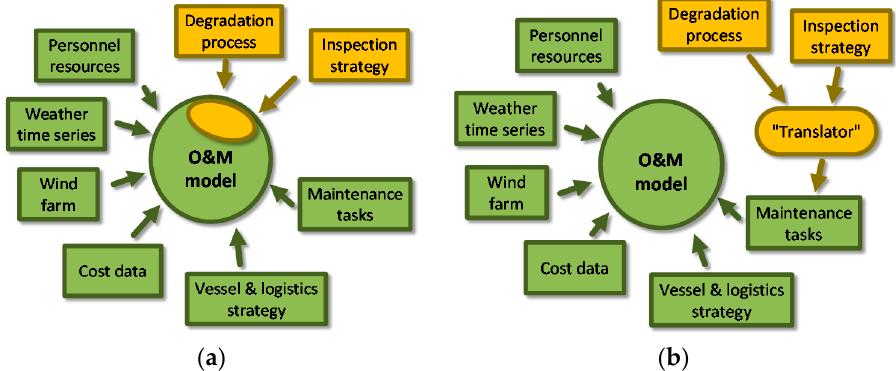
Figure 4. NOWIcob input parameters and a conceptual illustration of two alternative integration approaches: ( a ) full integration; ( b ) loose integration.